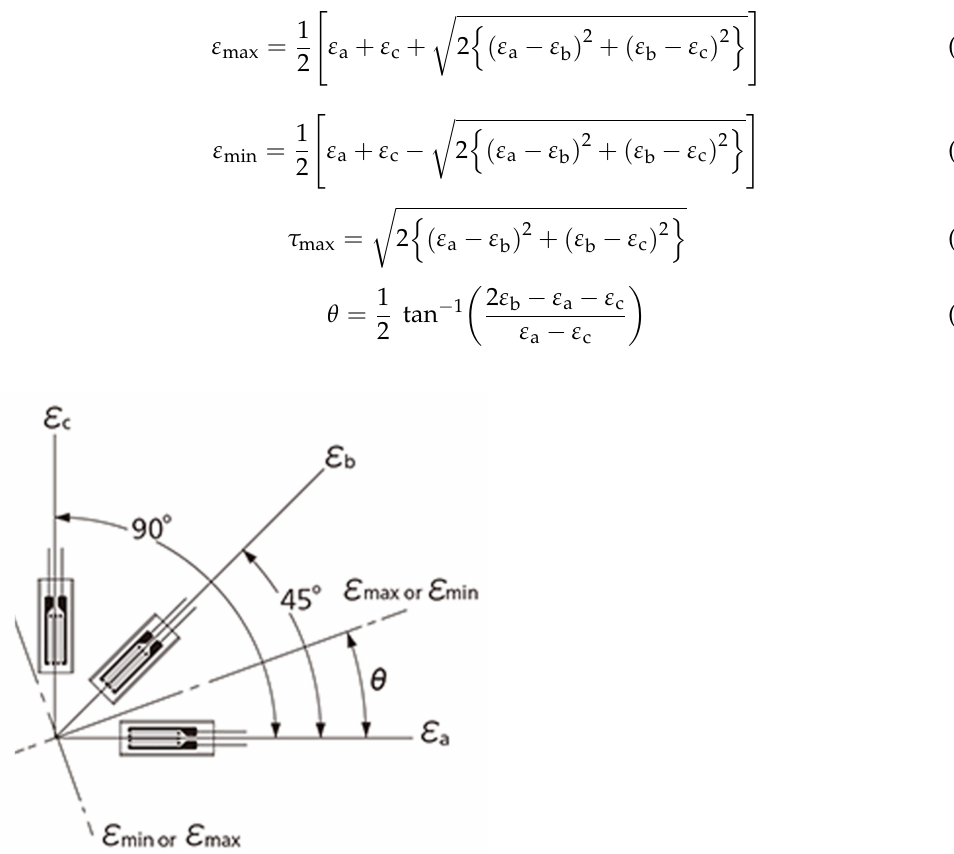
Figure 7. Concept of principal strains from the triaxial 0 ◦ –45 ◦ –90 ◦ rosette gauge